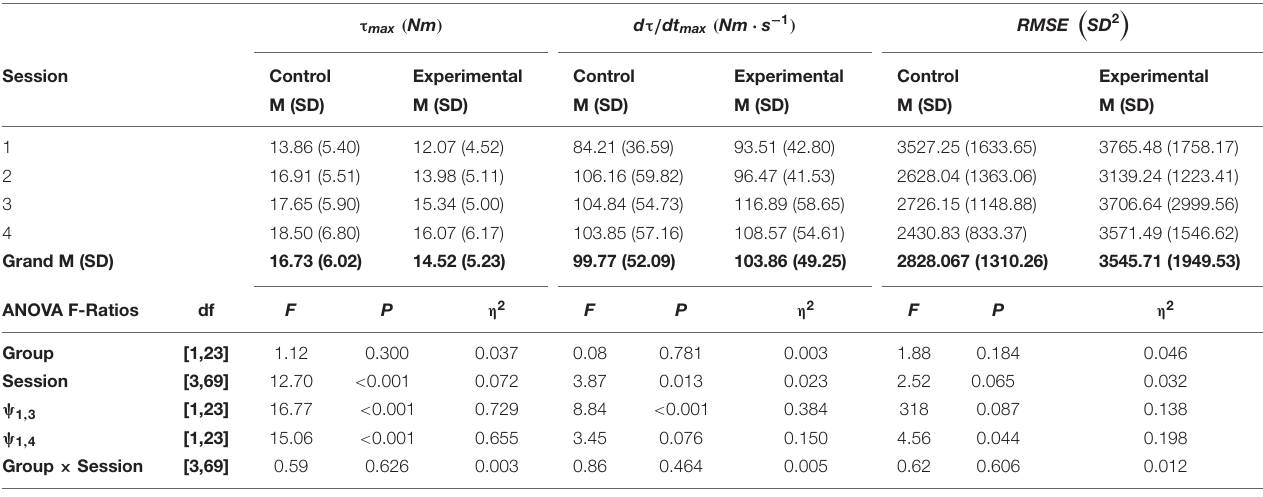
TABLE 2 | The means (M), standard deviations (SD), F -ratios, degrees of freedom ( df ) and probabilities ( P ), and η 2 effect sizes for maximum wrist flexion torque ( τ max ) , the maximum rate of torque development ( d τ / dt max ) , and the root-mean-square error (RMSE) of the phase plane trajectories calculated from ANOVAs with planned comparisons ( ψ ).